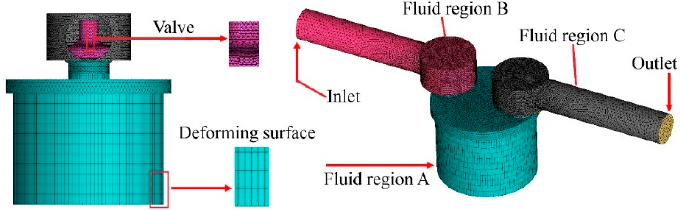
Figure 6. Computational domains of the FPE.